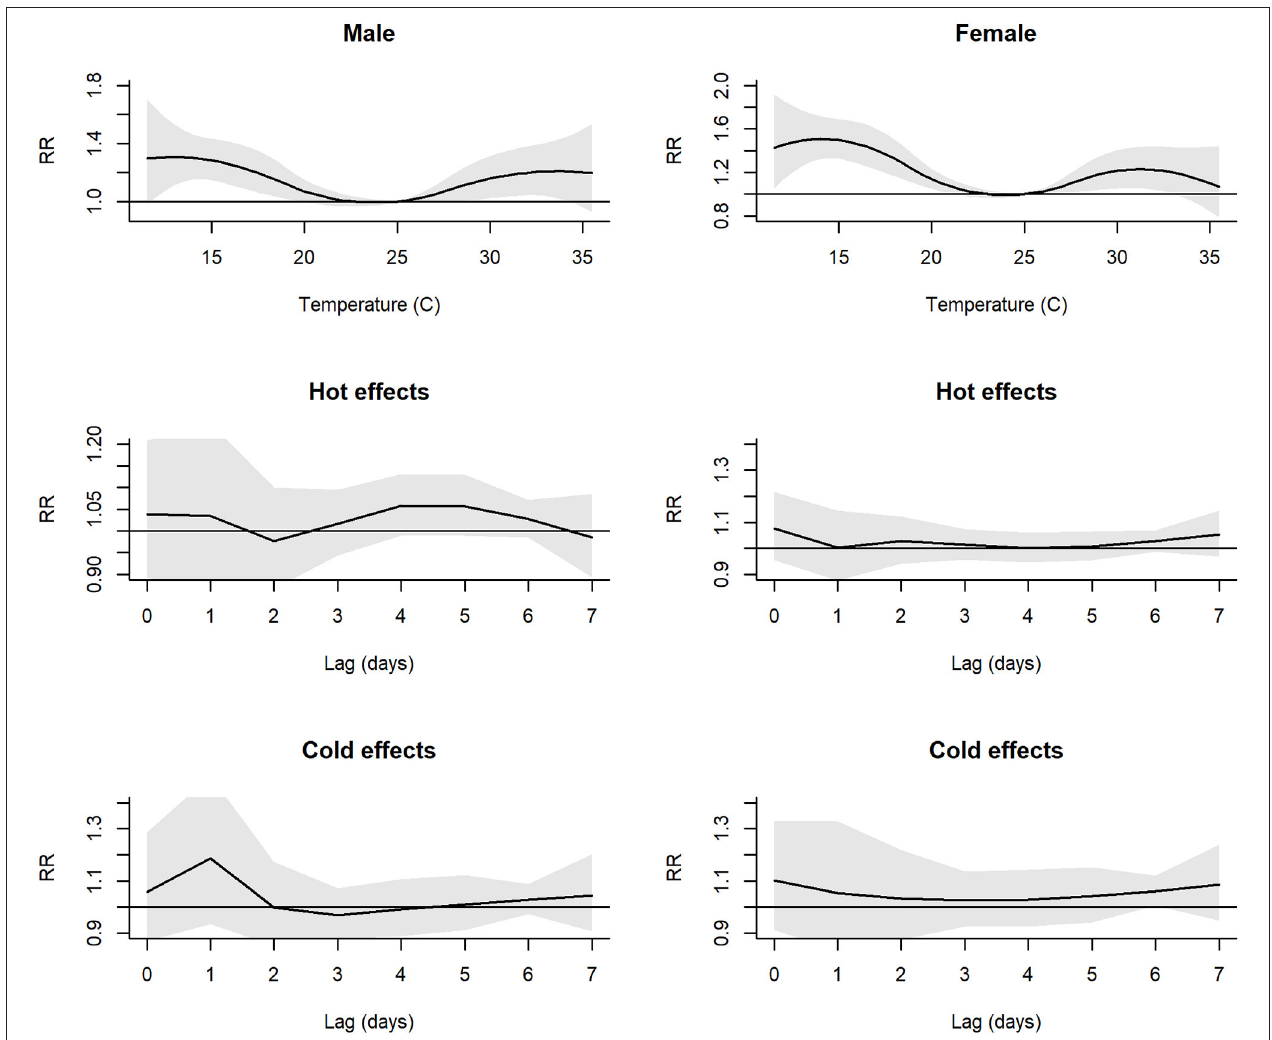
FIGURE 2 | Plot of RR between daily mean temperature and hospital admissions and individual lag-response curves for hot and cold effects, stratified by genders. Shaded areas denote 95%